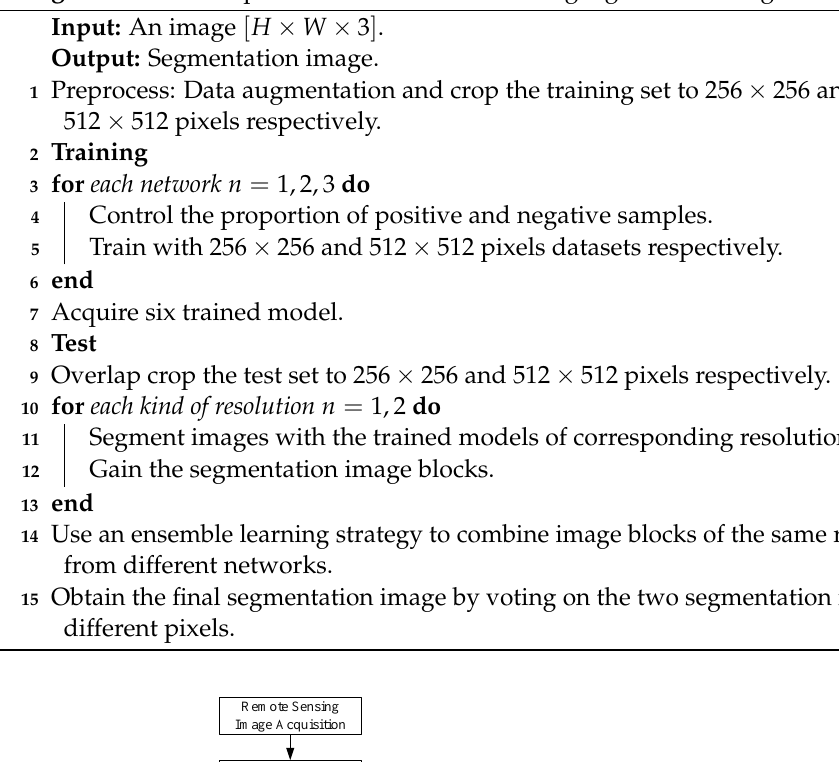
Algorithm 1: Description of the ensemble learning algorithm for segmentation